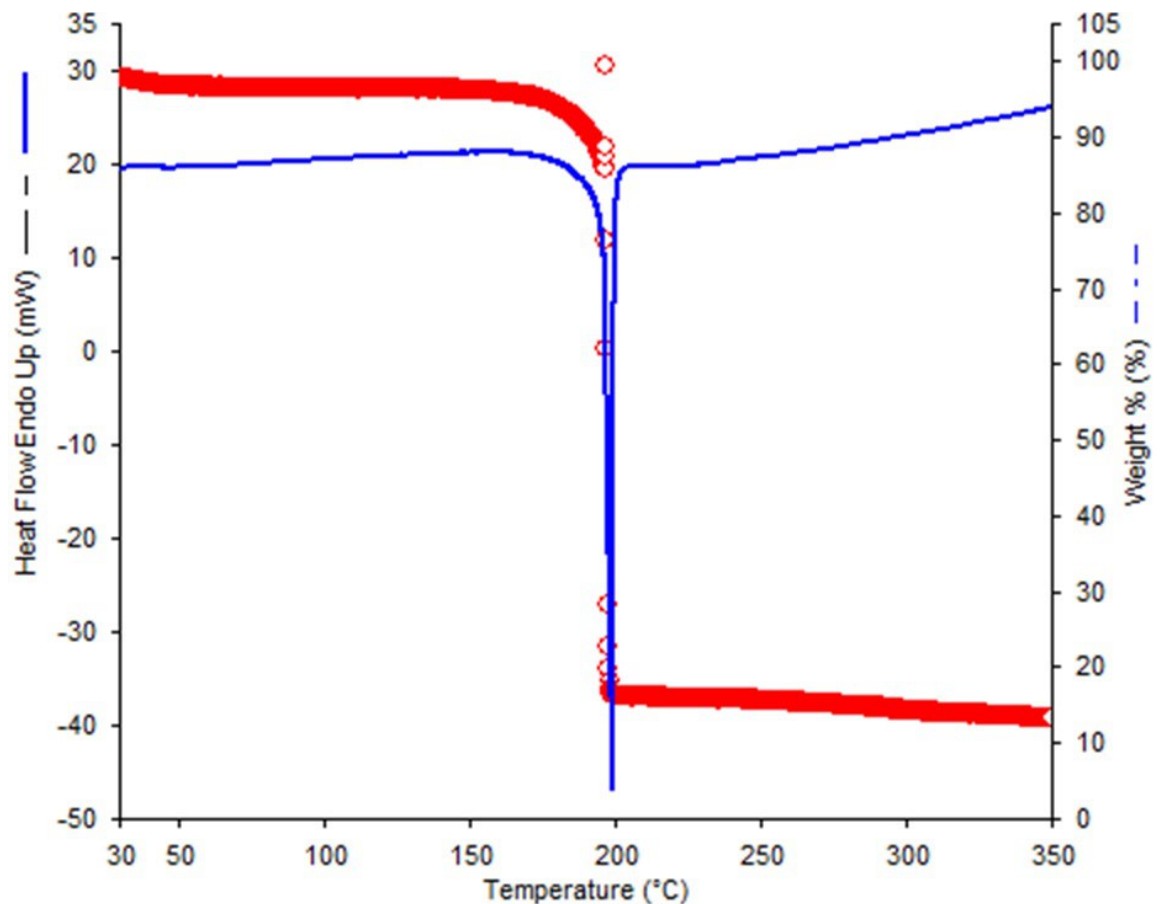
Figure 11. Thermogravimetric analysis of ( 6 ), 5-[2 (cid:48) -(Nitroxyethyl)nitramino]-4,6-dinitro-1,3- dihydrobenzimidazol-2-one at 5 ◦ C/min. The above thermal analysis (TGA, red line; DSC, blue line, deflagration stage is marked as red bubbles line) data clearly show that organic nitrato group (O 2 NOCH 2 CH 2 -) strongly decreases the decomposition temperature in the case of 5-[2 (cid:48) -(nitroxyethyl)nitramino]-4,6- dinitro-1,3-dihydro- 2H -benzimidazol-2-one (deflagration at 199–201 ◦ C) when compared to 5-methylnitramino-4,6-dinitro-1,3-dihydro- 2H -benzimidazol-2-one (deflagration at 278 ◦ C). Importantly, the thermal stability of both nitramine derivatives are substantially diminished in comparison with benzimidazol-2-one trinitro derivative TriNBO ( 1 ) (decomposition at 339 ◦